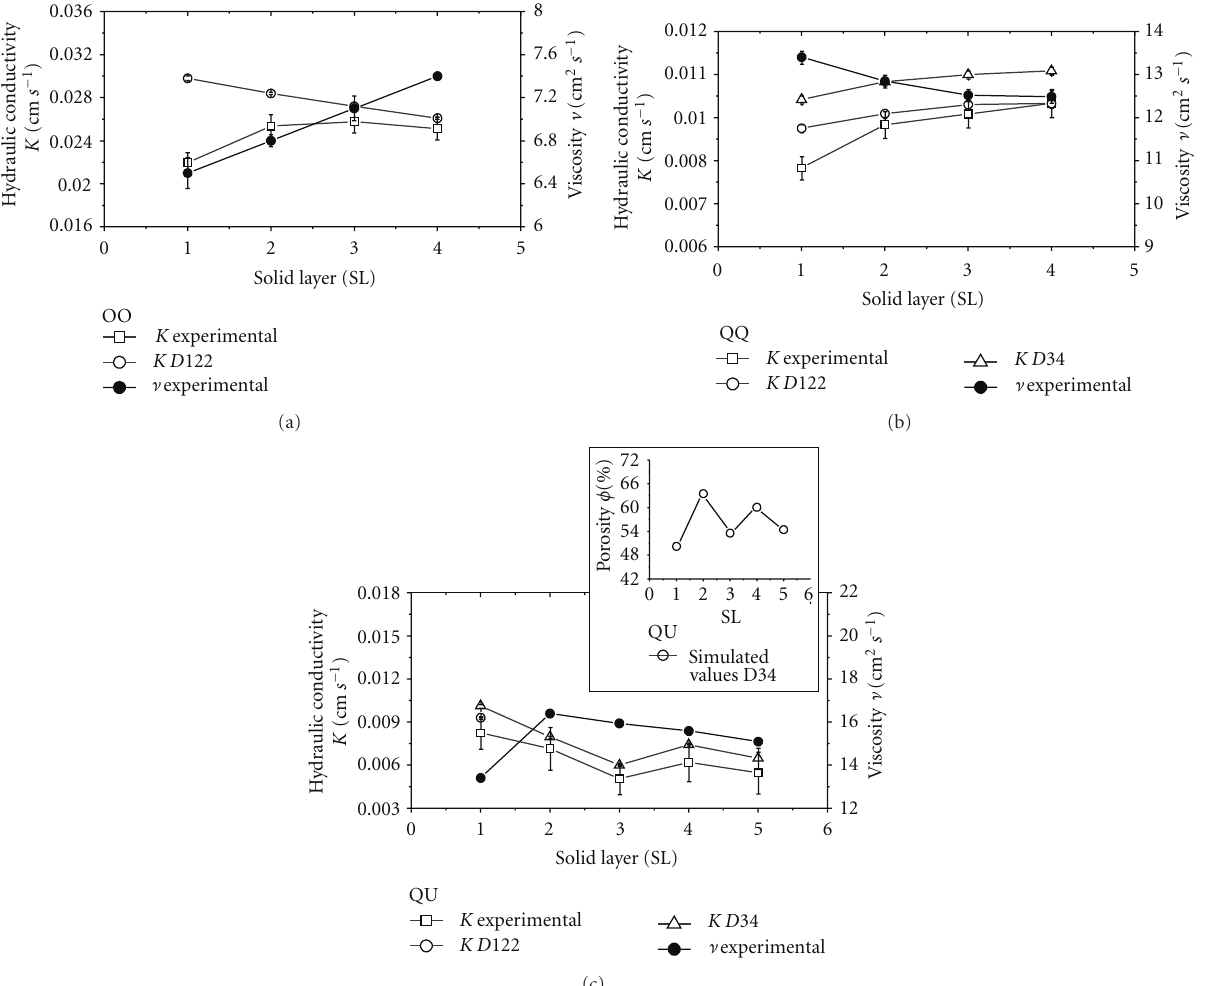
Figure 4: Experimental and simulated results of the hydraulic conductivity ( K ), glycerin experimental viscosity ( v ), and experimental porosity ( φ ) for: (a) OO arrangement; (b) QQ arrangement, and (c) QU arrangement. D 34 and D 122 represent the spheres diameter ( D ) with 34 and 122